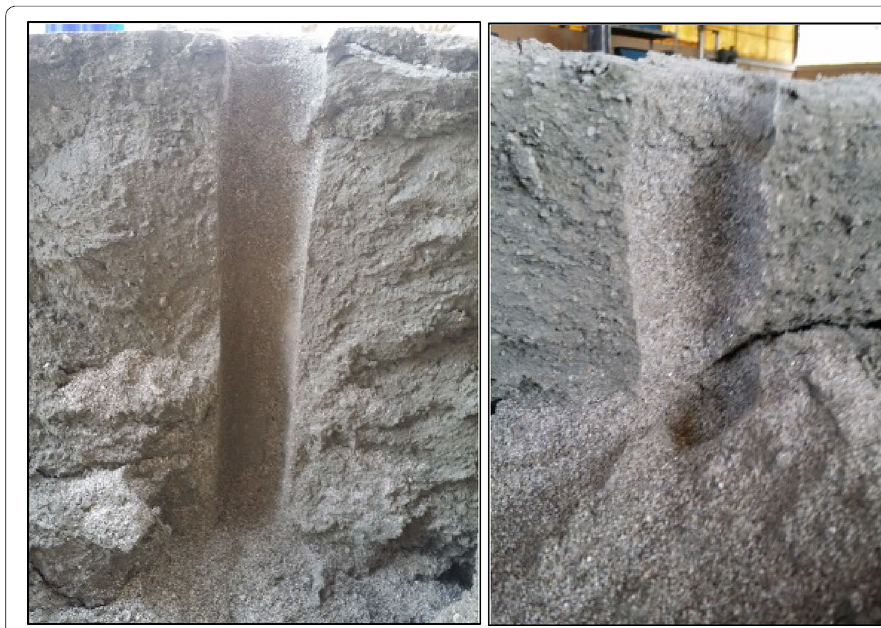
Fig. 14 Bulging of sand columns